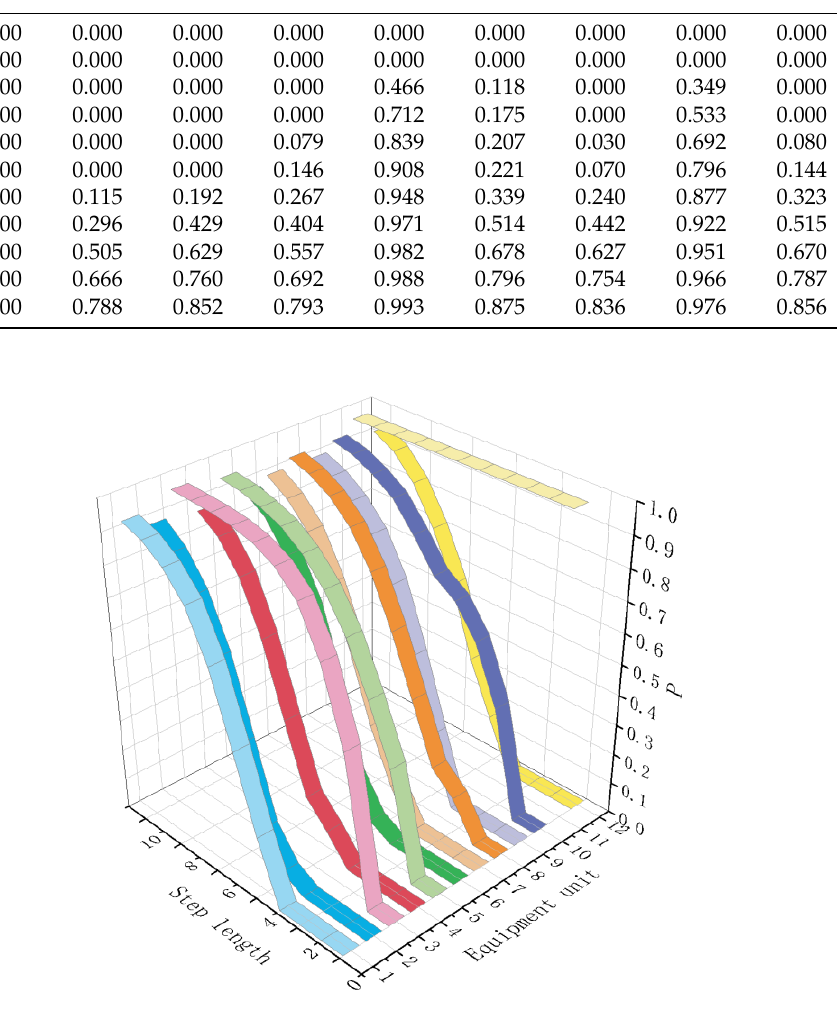
Figure 8. The fire probability of the equipment in the engine room changes at each time step when E11 is the initial fire source.